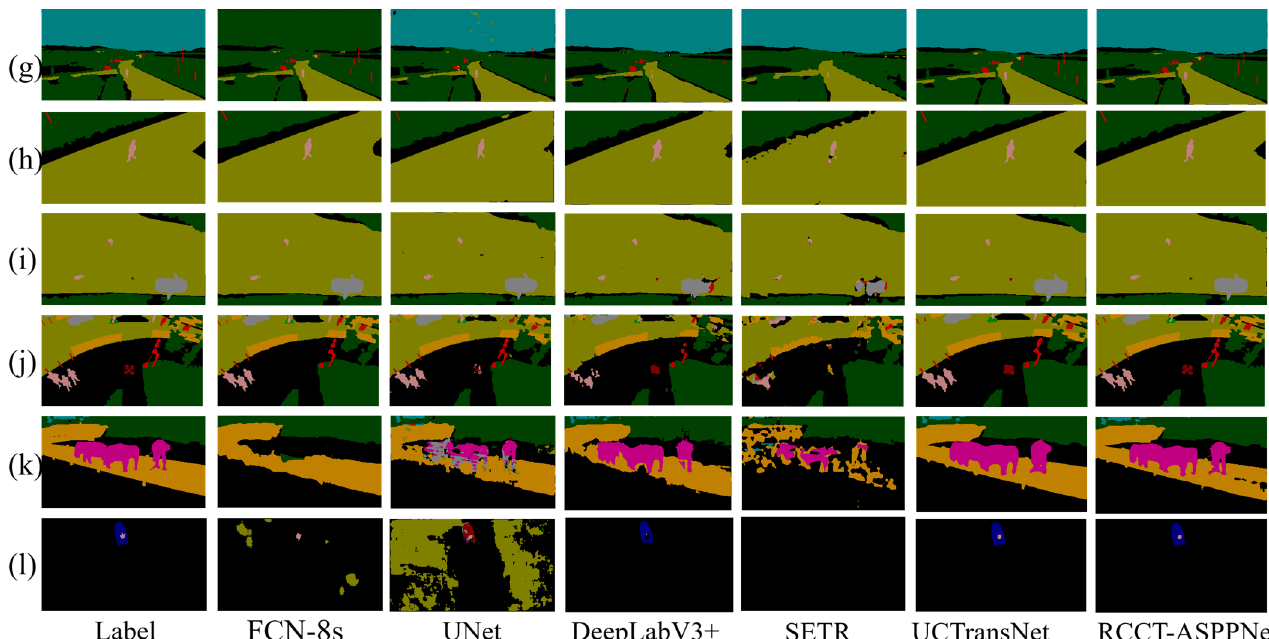
Figure 10. Farmland data prediction results, from left to right, are real labels, FCN, UNet, Deeo- LabV3+, SETR, UCTransNet, and RCCT-ASPPNet, from top to bottom, ( a – f ) are the selected 6 sets of Farmland test images.